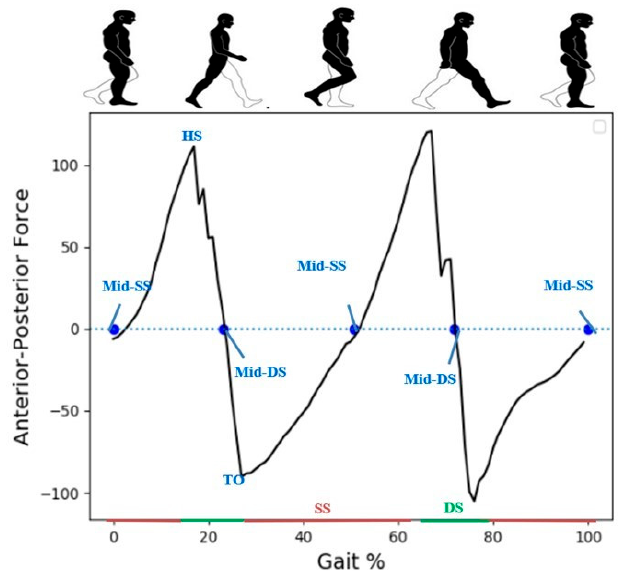
Figure 2. Healthy subject anterior-posterior force segmentation (SS: Single Stance, DS: Double Stance, TO: Toe off, HS: Heel strike).